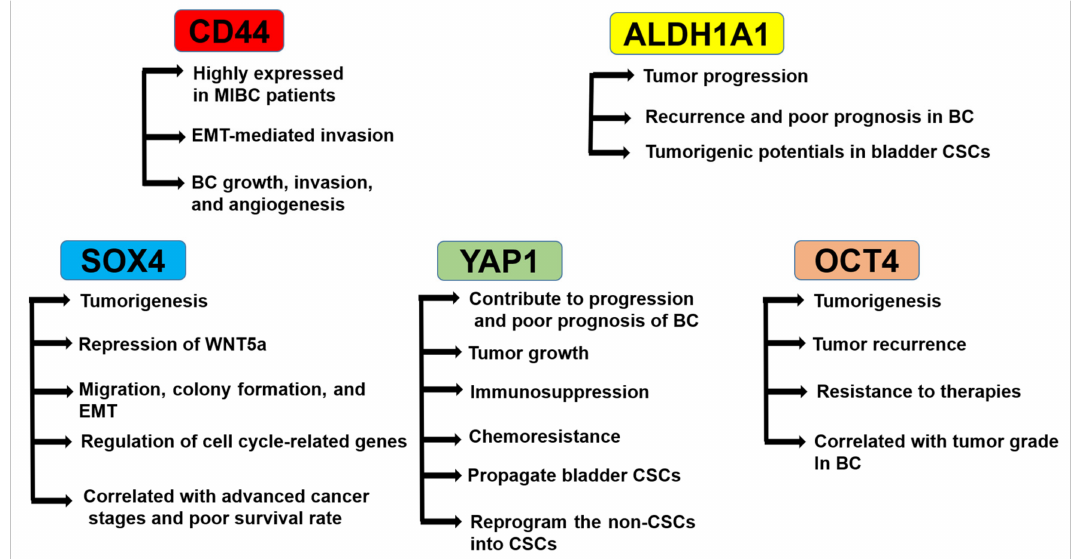
Figure 1. Roles of cancer stem cell (CSC) markers in bladder cancer (BC). CD44 is highly expressed in muscle-invasive (MI)BC patients, regulates epithelial-mesenchymal transition (EMT)-mediated invasion, and mediates BC growth, invasion, and angiogenesis. ALDH1A1 regulates tumor progression, recurrence and poor prognosis in BC, and tumorigenic potentials in bladder CSCs. SOX4 regulates tumorigenesis, repression of WNT5a, migration, colony formation, EMT, and the expression of cell cycle-related genes. The SOX4 expression is correlated with advanced cancer stages and poor survival rates. YAP1 regulates progression and poor prognosis of BC, tumor growth, immunosuppression, chemoresistance, propagation of bladder CSCs, and reprogramming of the non-CSCs into CSCs. OCT4 regulates tumorigenesis, tumor recurrence, and resistance to therapies. OCT4 expression is correlated with the tumor grade in